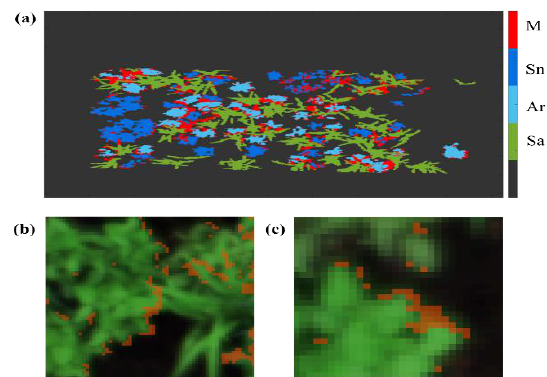
Figure 3 Misclassification location: an example for misclassified pixels locations on the ground truth image taken 14 days after sowing (a). Misclassification (M). is presented in red. The species in the scene are Solanum nigrum (Sn), Amaranthus retroflexus (Ar), and Seteria adherents (Sa). Selected regions of misclassifications in mixed pixels, overlayed on the RGB visualization of the hyperspectral image (b+c). The example given is an image taken 14 Days after sowing the weeds